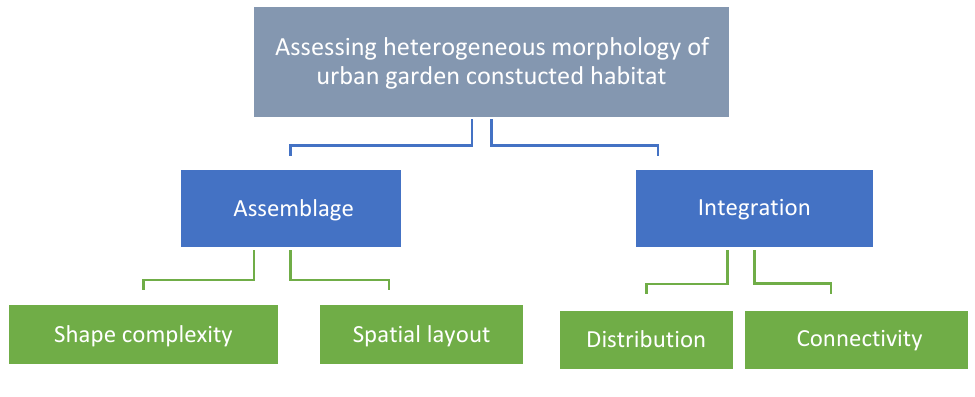
Figure 1 Research